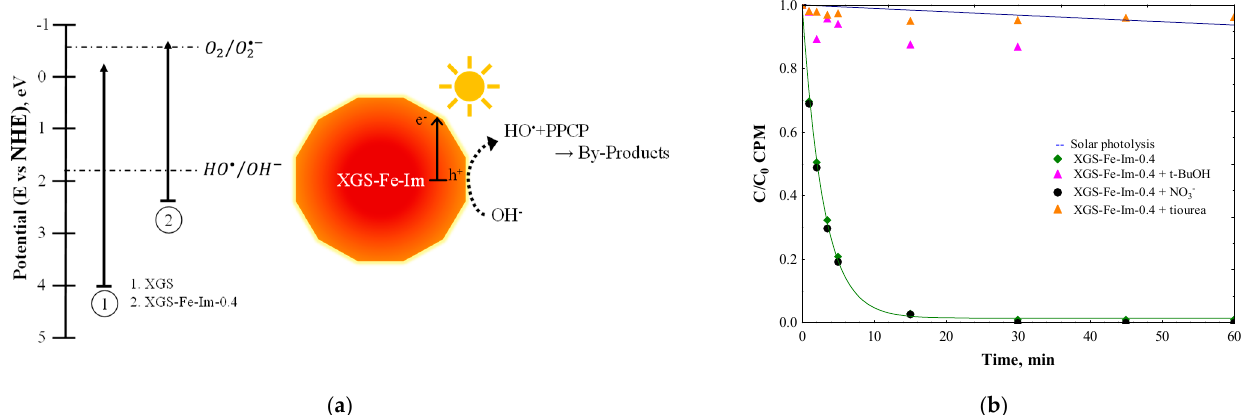
Figure 7. ( a ) Band structure of XGS and XGS-Fe-Im-0.4; ( b ) CPM degradation mechanism study using XGS-Fe-Im-0.4 and several scavengers. C 0 = 15 ppm.